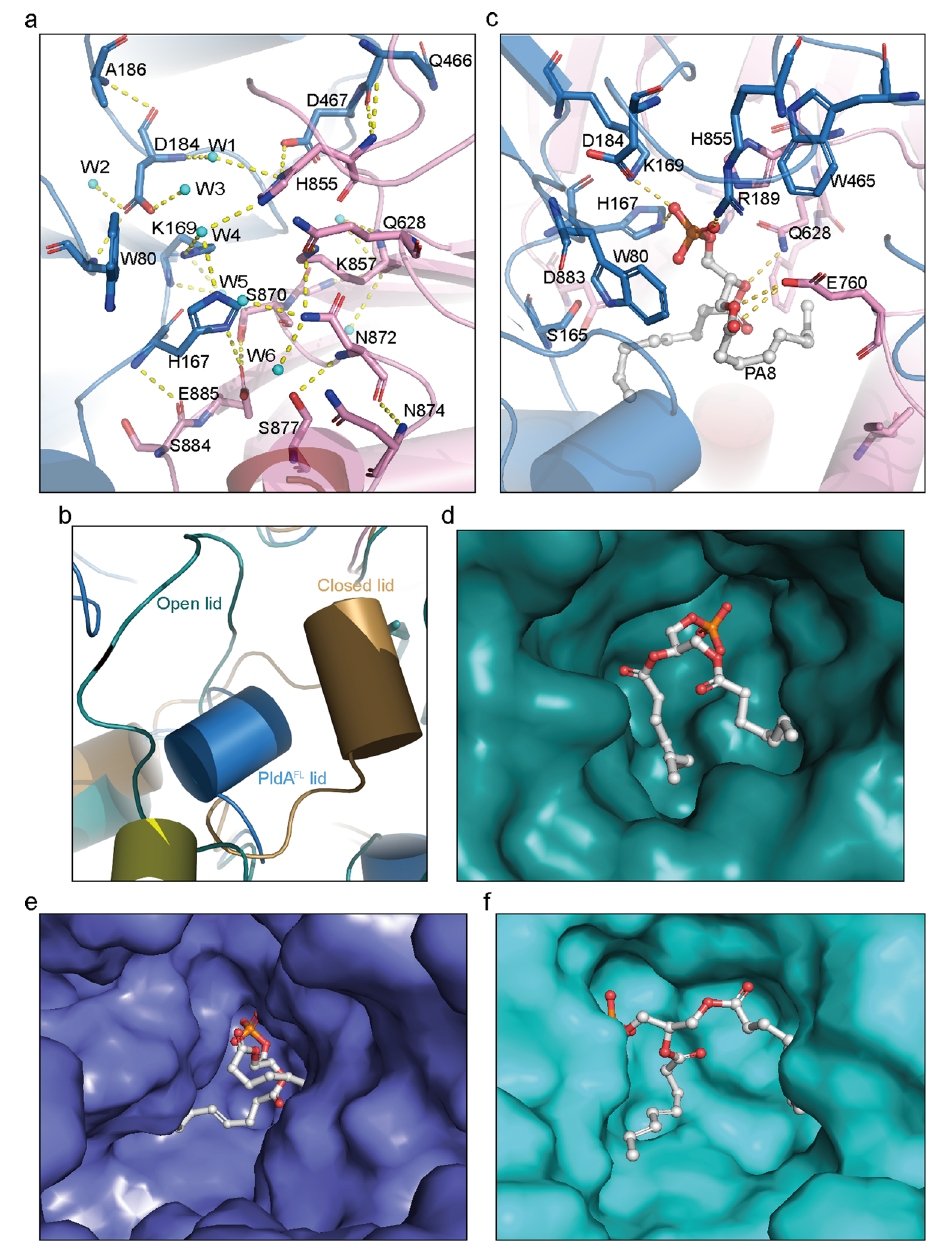
Fig. 2 | Catalytic pocket of PldA. a The hydrogen-bonding network present in the active site of PldA. Several water molecules (W1-W6) are involved in the hydrogen bond interaction with active site of PldA. b Comparison ofthe lid regions of PldA FL (slate) with closed (sand) and open A. thaliana PLD α (dark teal). c – f The docking